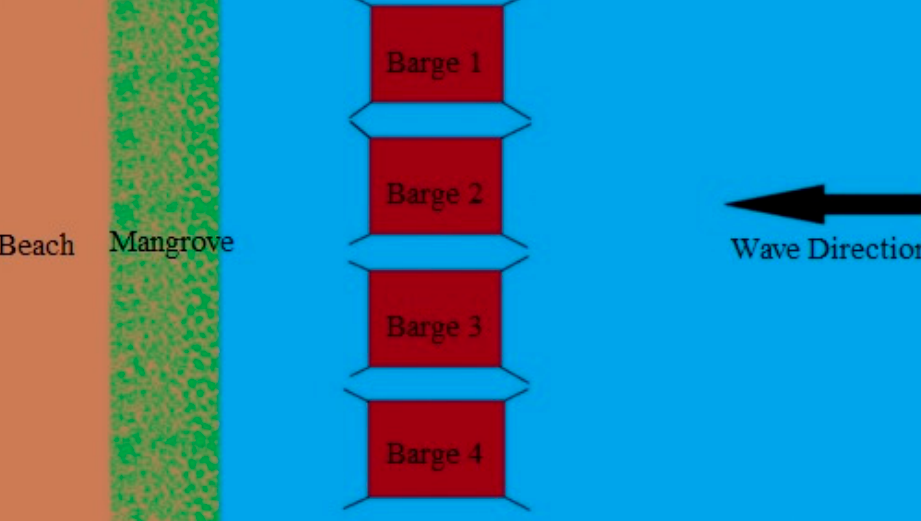
Figure 8. Moored barges in a series with mangroves planted on the beach.